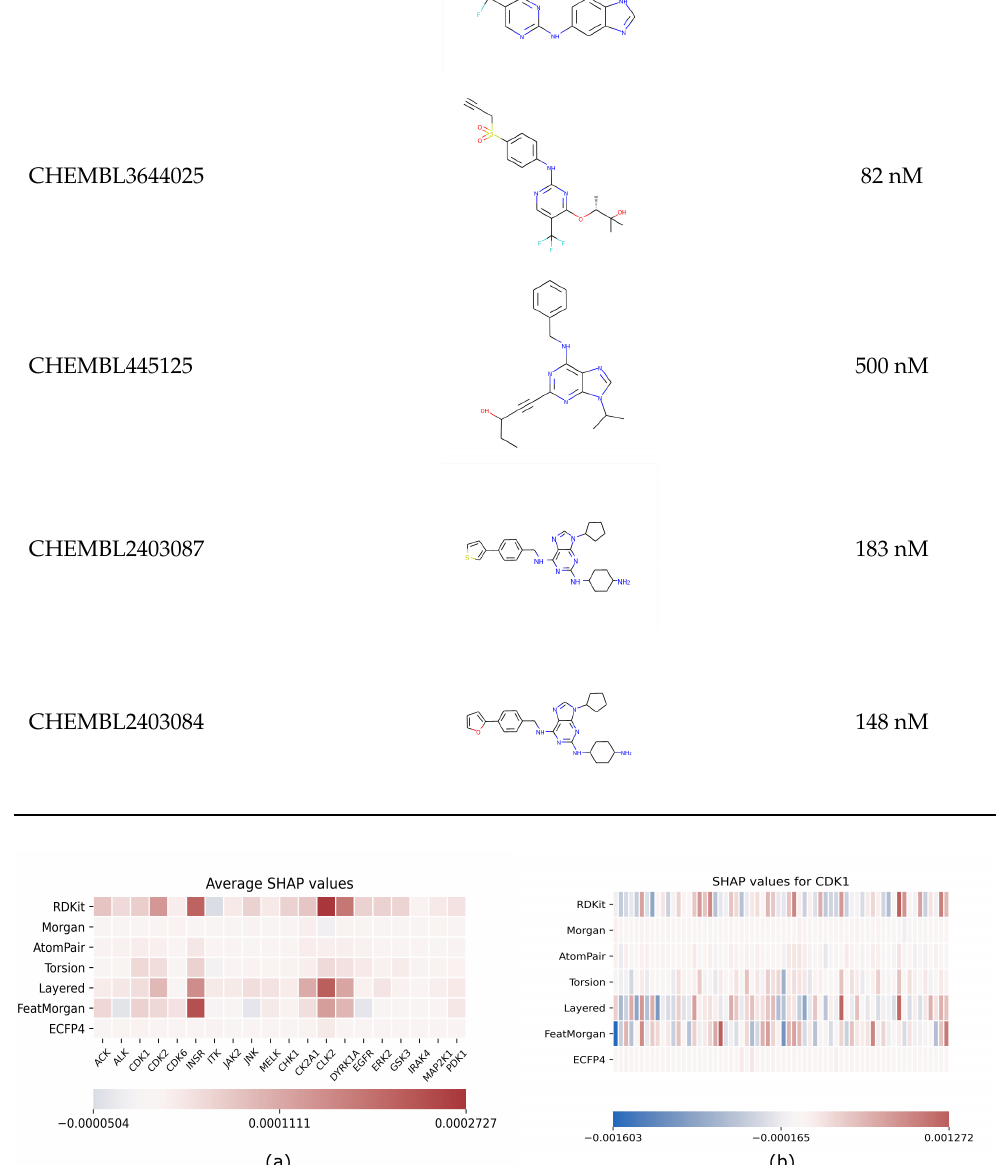
Figure 1. Explainability results using SHAP; ( a ) average SHAP values for each fingerprint computed on the entire test set separately for each target; ( b ) example of single target explainability analysis for CDK1: SHAP values are reported for each fingerprint, and each row has been grouped in 64 bins to enhance